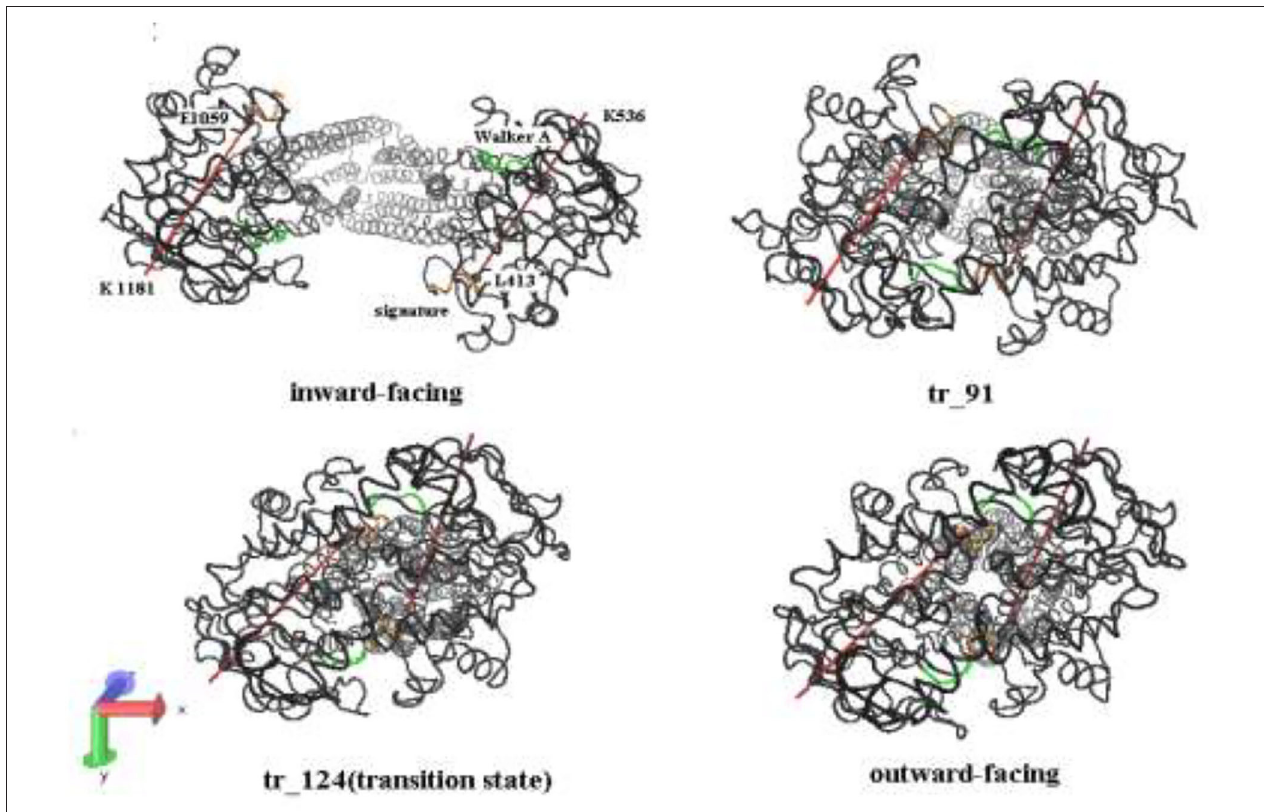
FIGURE 6 | A bottom-up view of human P-gp in different transition intermediates. The red lines represent the distance of residual pairs PA L413-PA K536 and PB E1059-PB K1181 in NBDs. The green and orange, respectively, mark the Walker A and signature motifs in NBDs.